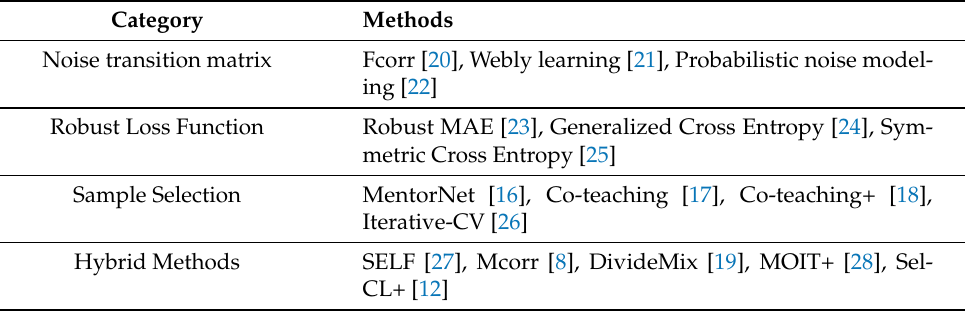
Table 1. Summary of literature reviewed according to the category of